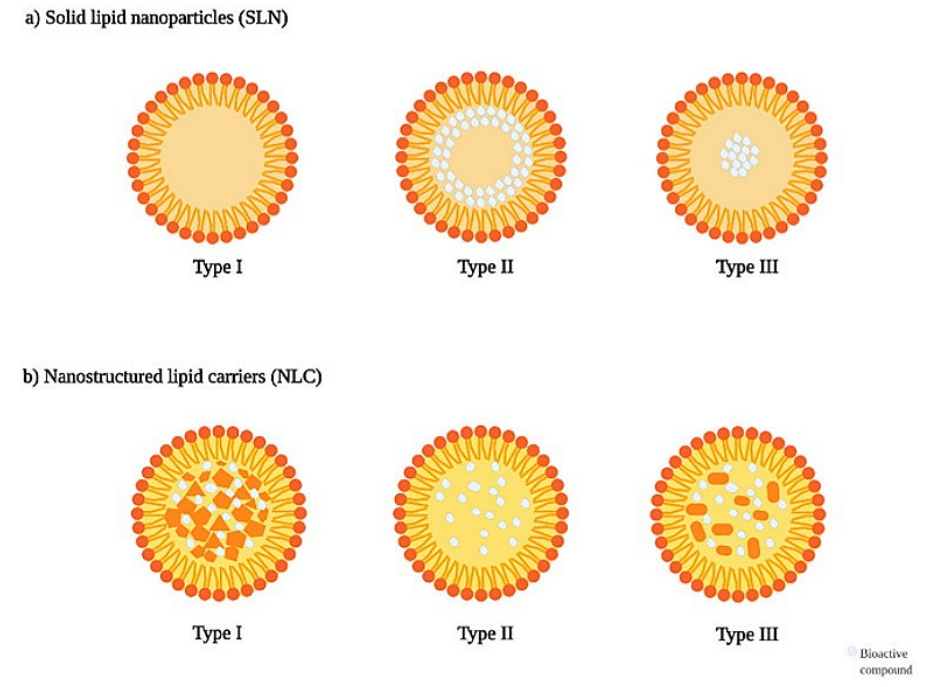
Figure 8. Classifications of ( a ) solid lipid nanoparticles (SLNs); ( b ) nanostructured lipid carriers (NLCs). Adapted from reference [172].